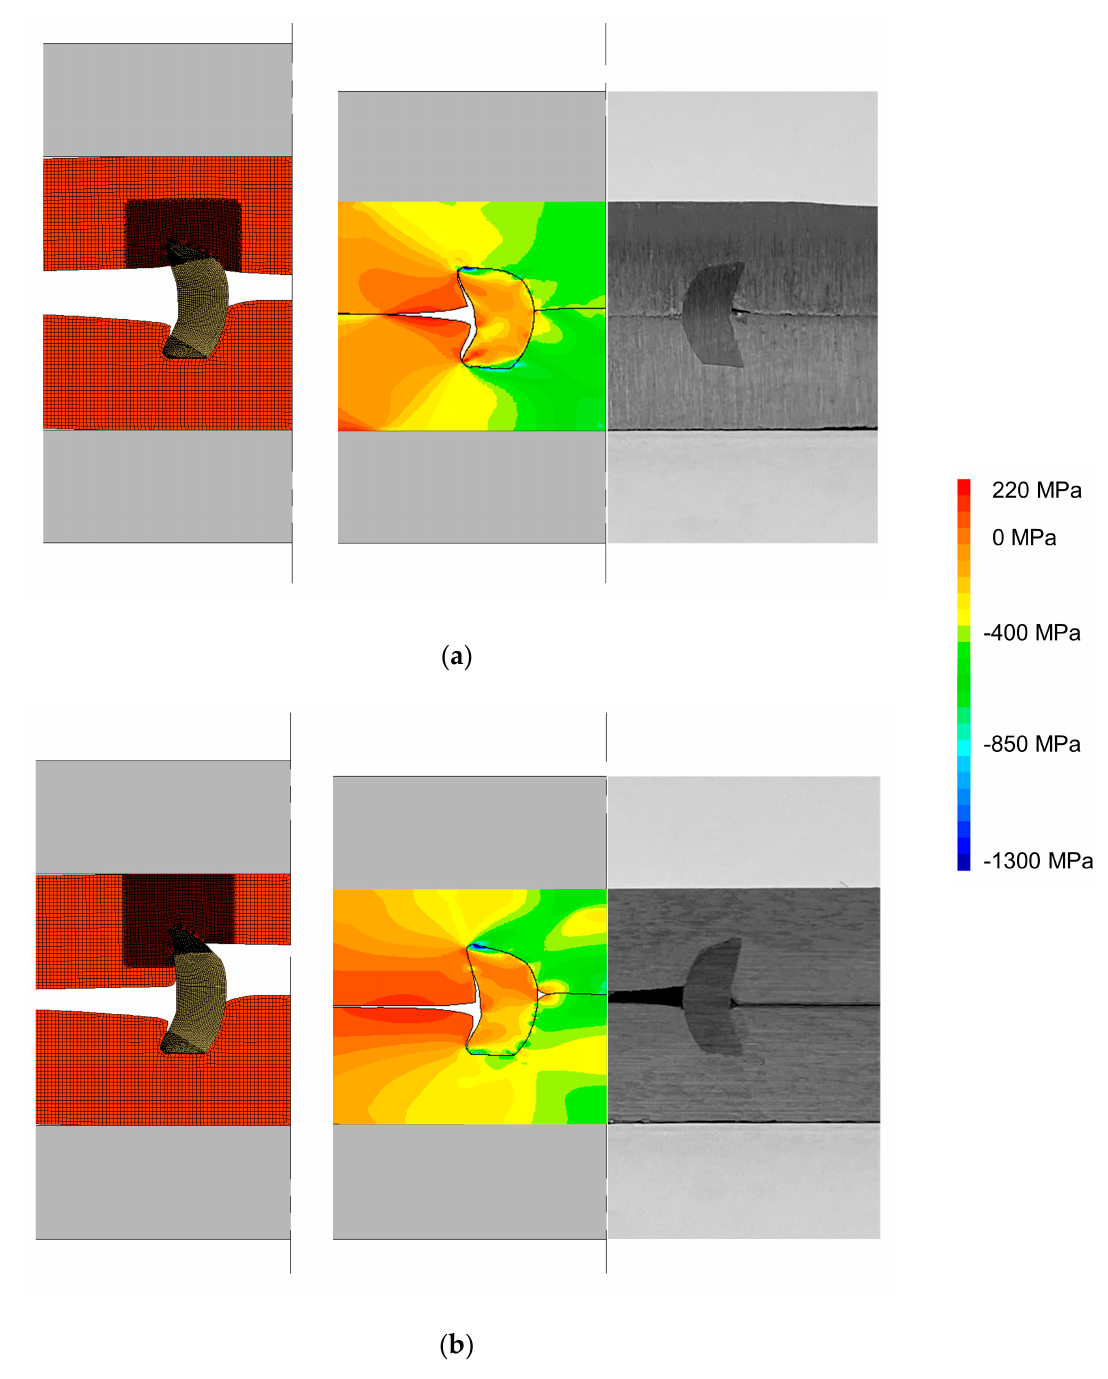
Figure 8. Evolution of DSSPR when joining a pre-riveted lower sheet to an upper sheet with ( a ) and ( b ) without a flat-bottom hole.